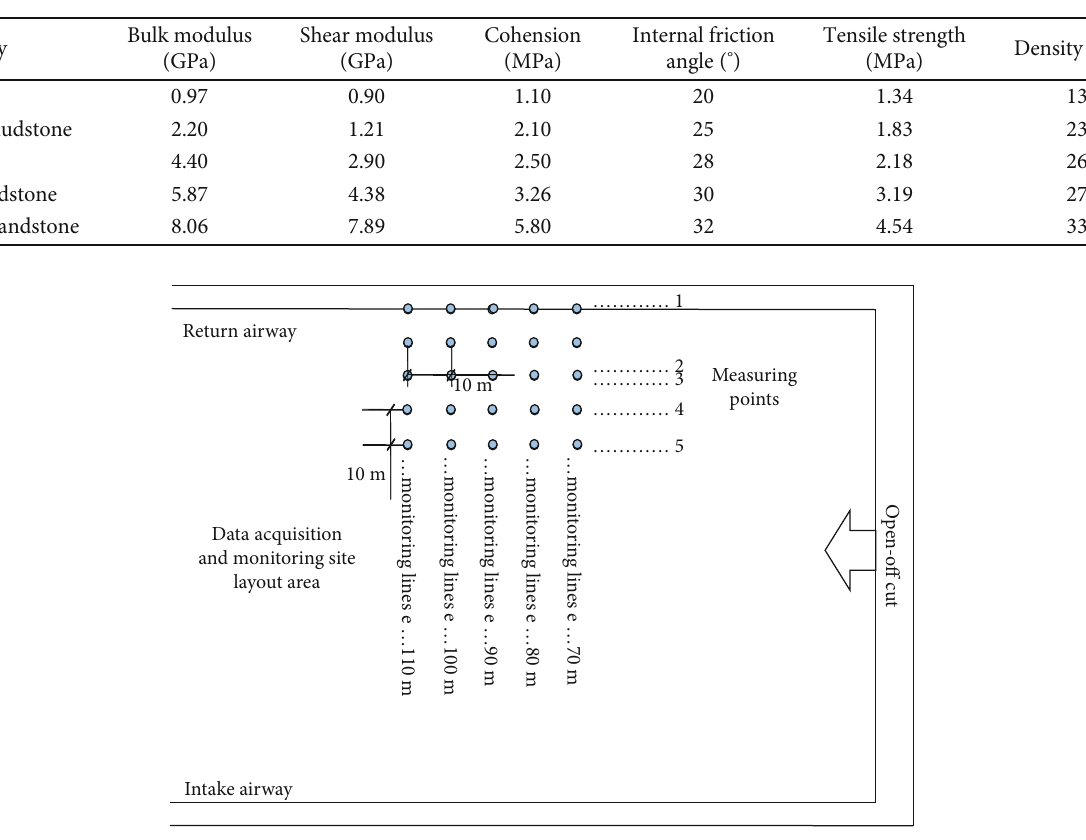
Table 3: Lithology parameters.